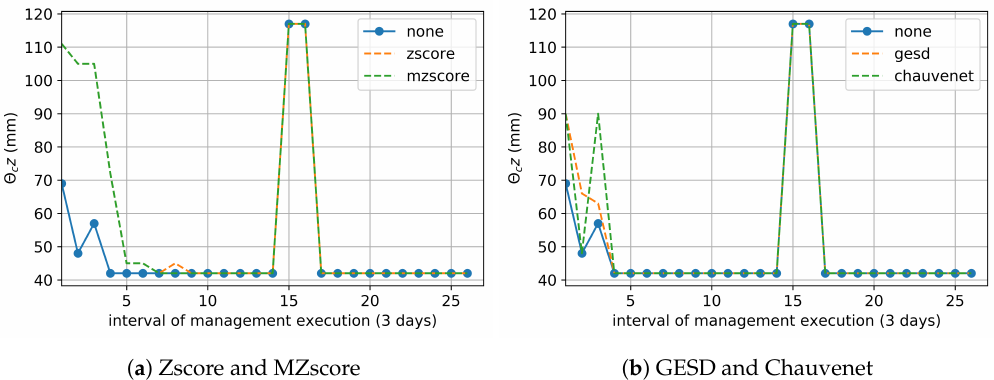
Figure 5. Real Moisture Data used in Water Balance—the points outside of the dashed lines are the current moisture data θ c z modified by an outlier removal technique.